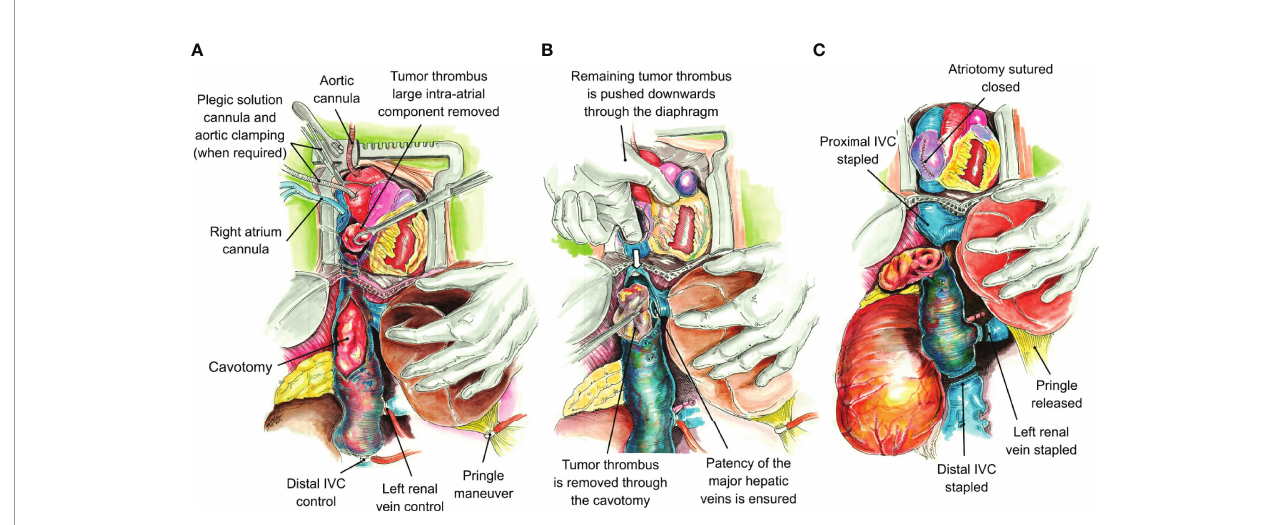
FIGURE 3 | Tumor thrombus removal by means of cardiopulmonary bypass. Cannulae are placed in the aortic root and the right atrium. If cardiac arrest is required, a vascular clamp is placed at the aortic arch proximally, and an additional cannula is placed for plegic solution release. Pringle maneuver is initiated, a right atriotomy is performed, and the large component of the tumor thrombus occupying the right atrium is removed through the atriotomy (A) . The remaining tumor thrombus in the right atrium and proximal inferior vena cava is pushed downward through the atriotomy in a caudal direction. A longitudinal cavotomy permits the removal of the remaining tumor thrombus under direct visual control, ensuring the patency of the major hepatic veins ostia at the same time (B) . Once the cranial thrombus component is removed, the inferior vena cava is stapled below the entrance of the major hepatic veins, the atriotomy is sutured closed, and the Pringle maneuver is released to reestablish the vascular fl ow into the liver. The procedure is completed by stapling the inferior vena cava distally and the left renal vein close to its ostium (C) .